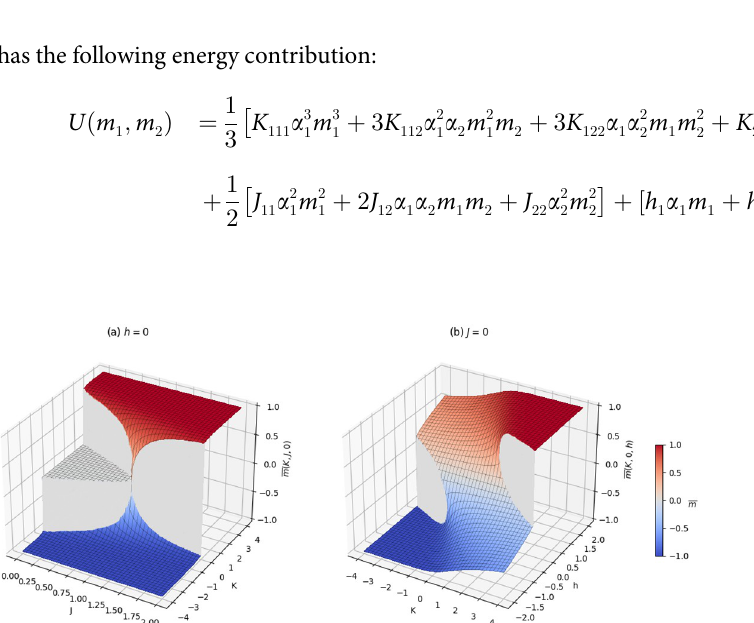
Fig 2. Average opinion surfaces of the cubic mean-field model. In panel (a) , h = 0 while in (b) J = 0. When J = 0 in (a) , we observe the global stable solution found in Fig 1 which indicates jumps at K solution of the simple Ising model without cubic interaction. For fixed J < 1 and moving along K the system presents two jumps separated by a plateau at zero. Those two jumps coalesce into a single one when J cross the unit value. In (b) we observe a discontinuity in the average opinion for two separated jumps when h and K falls within certain thresholds.